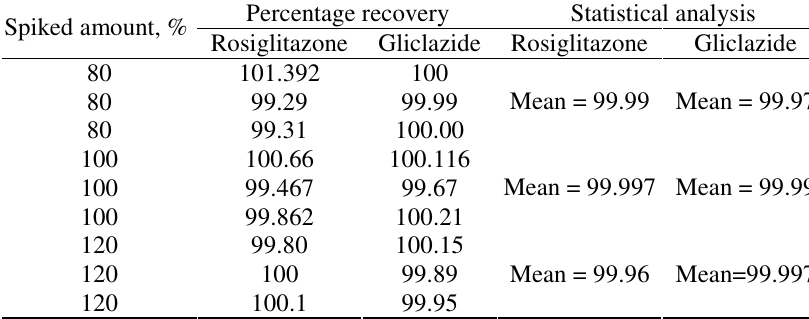
Figure 5. HPLC chromatogram for standard (Gliclazide). Table 2. Accuracy.